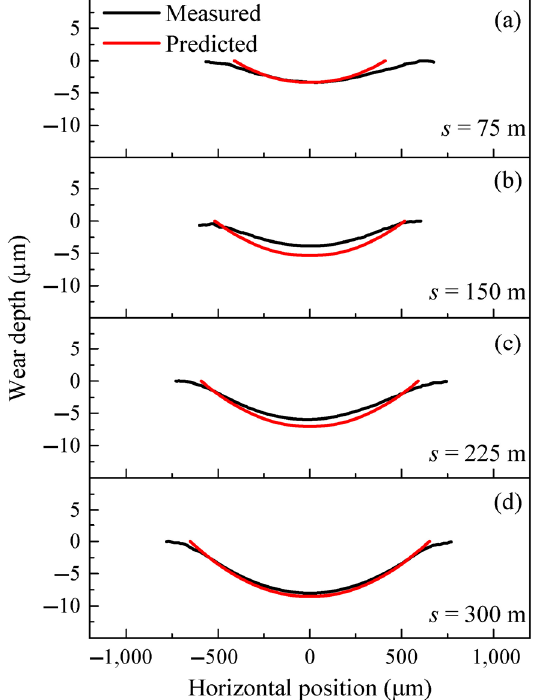
Fig. 10 Comparison of numerical prediction and experimental results for worn surface profiles of the flat specimen after sliding: (a) 75 m; (b) 150 m; (c) 225 m; (d) 300 m.